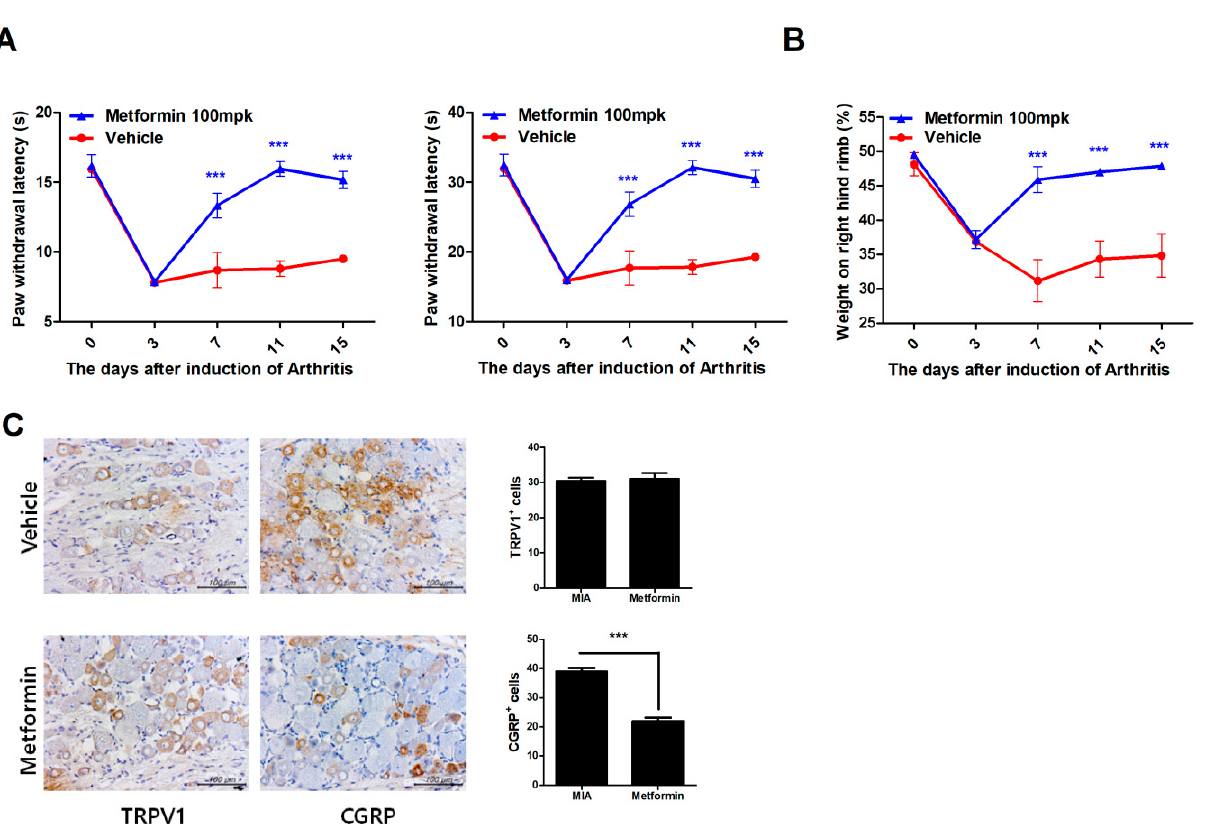
Figure 1. Metformin reduces pain in monosodium iodoacetate (MIA)-induced OA rats. The rats were injected with 3 mg of MIA. After osteoarthritis (OA) induction, the rats were administrated with metformin 100 mg/kg (N = 6 animals per group). ( A ) Nociceptive testing was performed using a dynamic plantar aesthesiometer (Ugo Basile, Gemonio, Italy), an automated version of the von Frey hair assessment procedure. ( B ) Weight-bearing was assessed using an incapacitance meter (IITC Life Science, Woodland Hills, CA, USA). ( C ) Dorsal root ganglion tissue from rats in all groups was stained immunohistochemically with specific antibodies for CGRP and TRPV1. Immunohistochemically identified TRPV1- and CGRP-positive cells were counted. Data are represented as the mean ± standard error of the mean (SEM) of three independent experiments (*** p < 0.001).